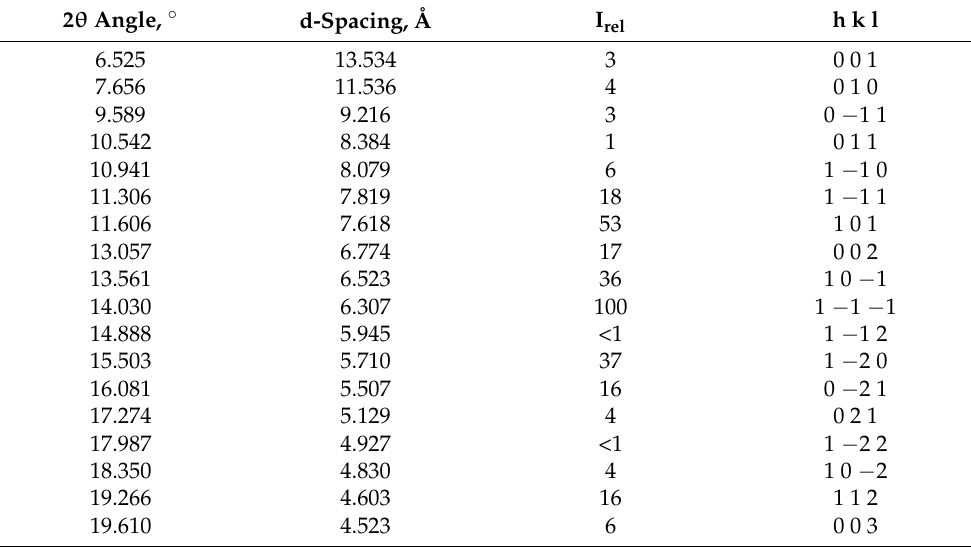
Table 13. List of observed 2 θ angles, d-spacings, and relative intensities, jointly with reflection indices, for Eltrombopag